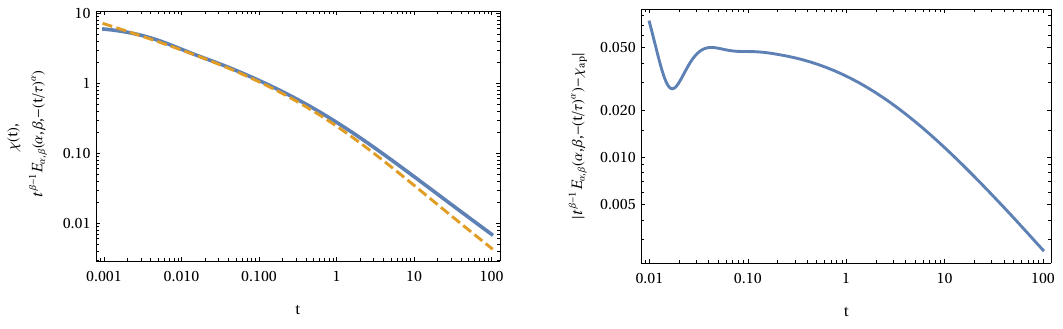
Figure 15. Solution of the fractional relaxation Equation (96) generated by the inverse Laplace transform of ˜ G ( s ) . The left panel also includes the two parameter ML function t β − 1 E α . β ( − ( t / τ ) α ) as a reference. The right panel shows the local error between the reference and the approximation. The number of approximation points used in the calculation was m = 2 n + 1 = 35. The parameters to generate the plot are χ 0 = 1, τ = 1, α = 1/2, β = 2/3, and γ =